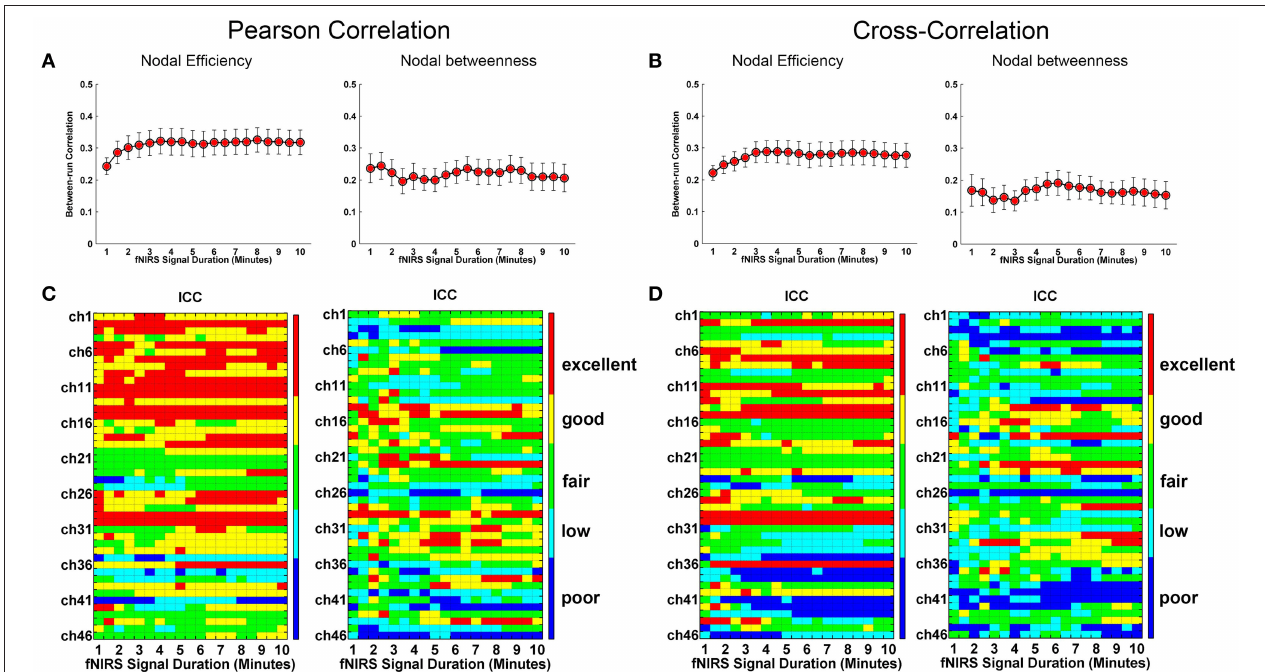
FIGURE 6 | Evaluation of the effect of fNIRS signal acquisition duration on the reproducibility of nodal efficiency and nodal betweenness. The nodal efficiency and nodal betweenness in (A) and (C) were calculated from Pearson correlation-derived networks. (A) Between-run correlation coefficients for nodal efficiency and nodal betweenness plotted by duration of fNIRS signal acquisition (1.0 10.0 min in 30-s bins), respectively. The red-filled shapes indicate significant correlations in the ∼ spatial patterns between two runs at the same signal acquisition bin for nodal efficiency and nodal betweenness, respectively. (C) The ICC values for nodal efficiency and nodal betweenness, respectively. (B) was similar to (A) and (D) was similar to (C) except that the nodal efficiency and nodal betweenness were calculated from cross-correlation-derived